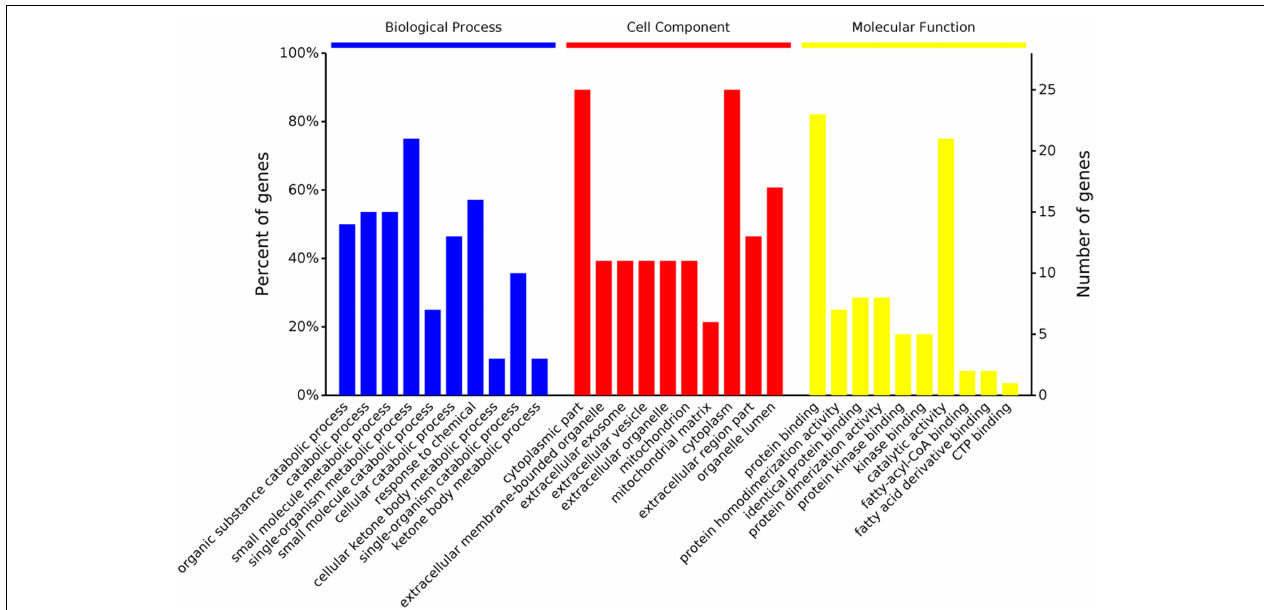
FIGURE 2 | Gene ontology distribution analysis of differentially expressed proteins in the rumen epithelium in goats from the high grain (HG) group and the hay (Hay) group.